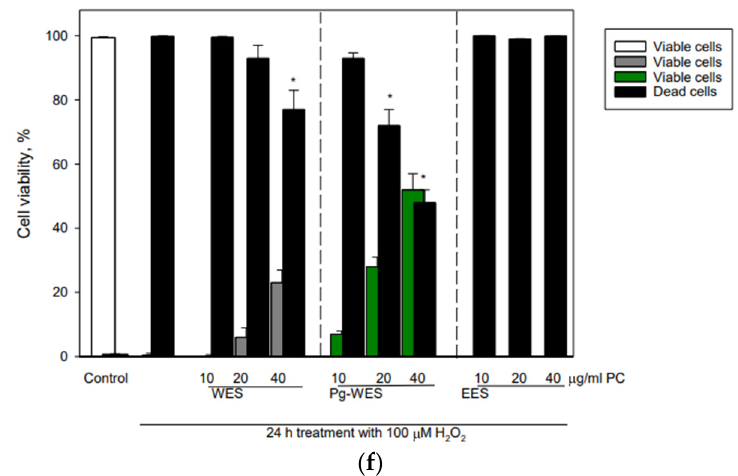
Figure 3. Effectivity of differently prepared extracts from elderflowers in sustaining the viability of glial cells under oxidative stress conditions. Cells were incubated for 24 h with 100 µM H 2 O 2 or appropriate solvent (control) and additionally in the presence of various concentrations of the elder- flower extracts. At the end of experiment, the cells were double-stained with Hoechst 33,342 and PI, and the viability was assessed under fluorescence microscope. Original magnification ×20. For de- tails, see the Materials and Methods section. Typical photographs of cells after treatment with ( a ) Control, ( b ) 100 µ M H 2 O 2 , ( c ) 100 µ M H 2 O 2 and 40 µ g/mL PC of WES, ( d ) 100 µ M H 2 O 2 and 40 µ g/mL PC of Pg-WES, ( e ) 100 µ M H 2 O 2 and 40 µ g/mL PC EES, whereas ( f ) cell viability (%) after treatment with H 2 O 2 in the presence of WES, Pg-WES and EES. * statistically significant difference vs. H 2 O 2 100 µ M.